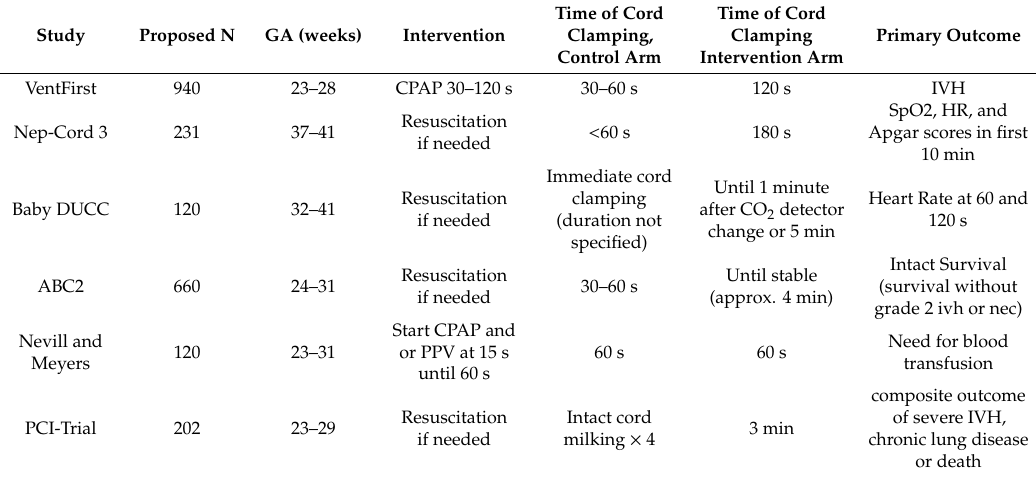
Table 2. Ongoing or planned trials of neonatal resuscitation